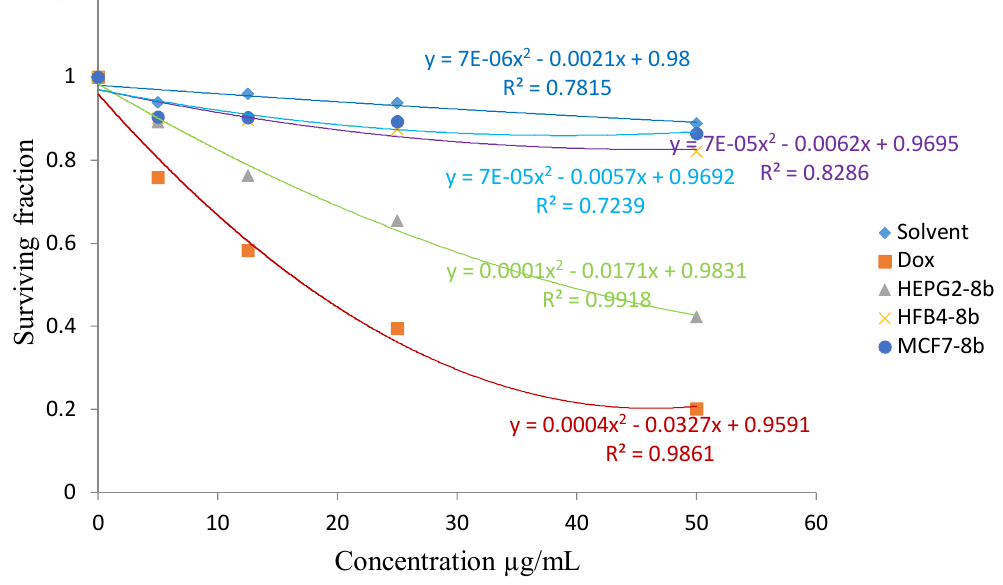
Figure 4. The cytotoxic activity of the synthesized product 8b against liver HEPG2 cancer cell line.